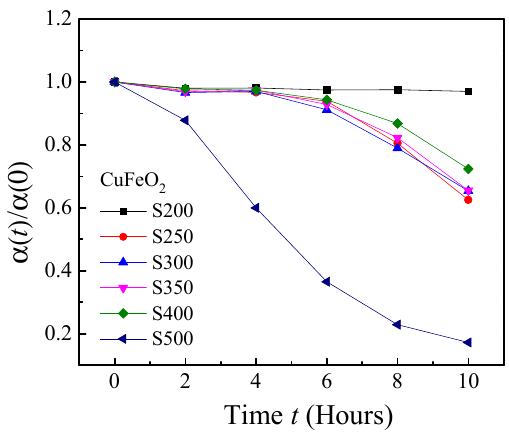
Figure 3. Catalytic activity of different Cu x Fe y O z NP samples: remaining concentrations of methyl orange after exposure to Cu x Fe y O z NP samples. Dark conditions were maintained throughout the entire process.